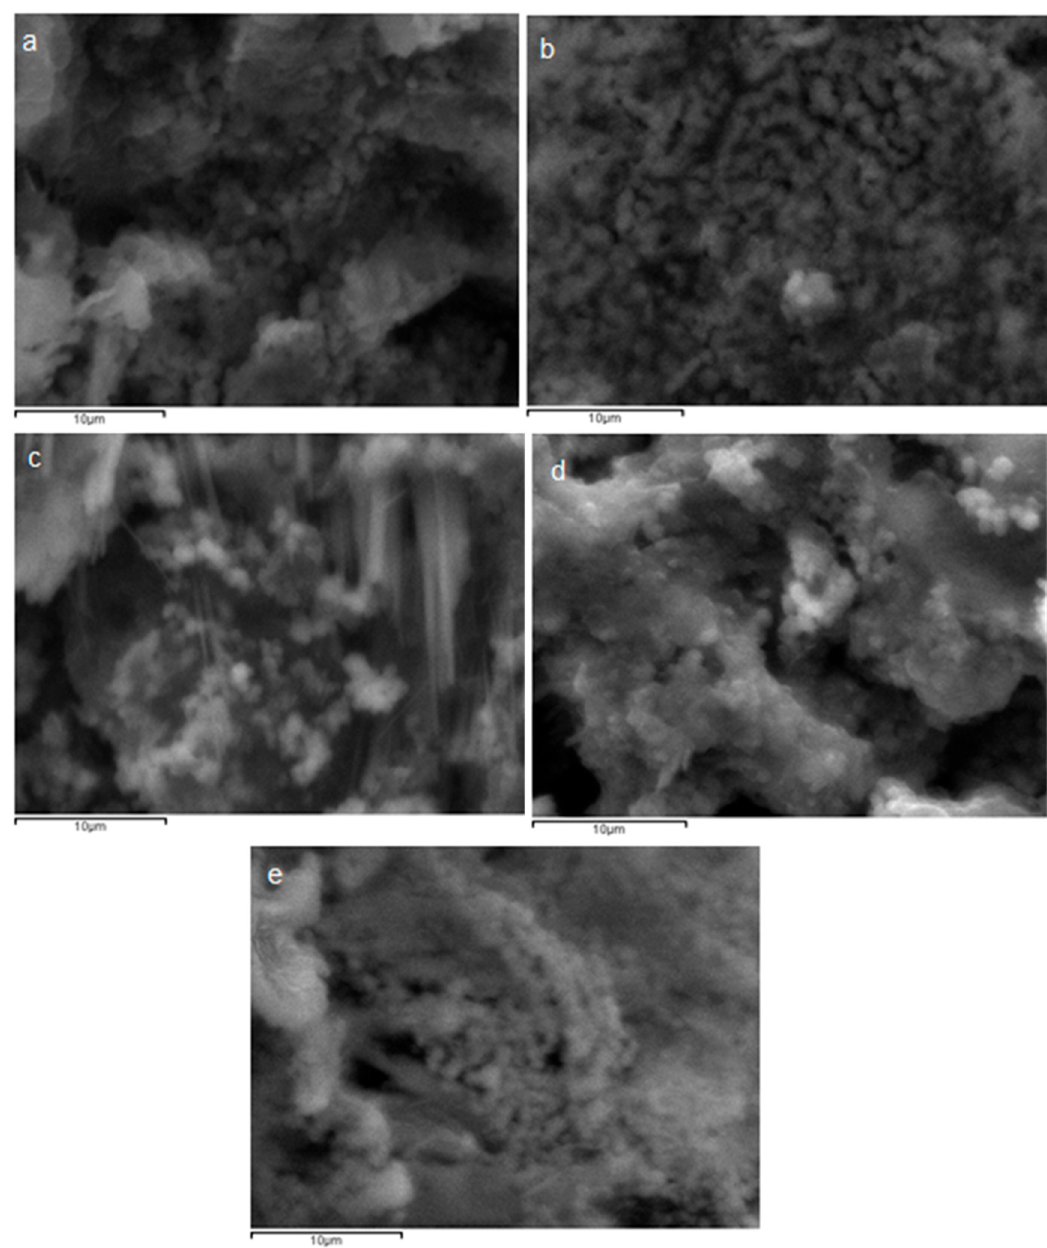
Figure 12. SEM photos of nanoparticles after dissolution study. ( a ) PLLA–GAL, ( b ) PLGA 75/25–GAL, ( c ) PLGA 65/35–GAL, ( d ) PLGA 75/25–HPC–GAL, and ( e ) PLGA 65/35–HPC–GAL.